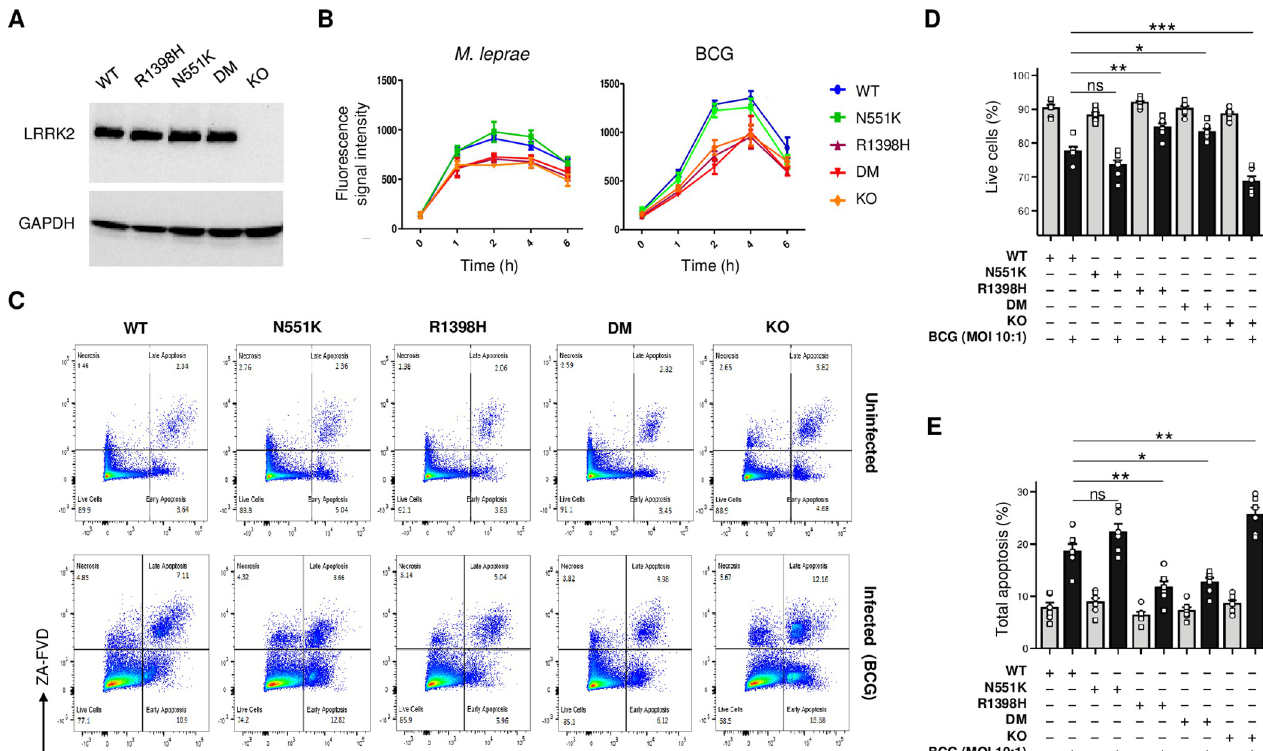
Fig 2. Effects of LRRK2 variants on respiratory burst and apoptosis in response to pathogens. (A) Protein levels in RAW264.7 cells of LRRK2 WT, LRRK2 mutants [N551K, R1398H and DM] and no LRRK2 protein (KO). The result is a representative of three independent experiments done by Western blot analysis. The expression of GAPDH is shown as a loading control. (B) Kinetics of reactive oxygen species (ROS) production in cells with different Lrrk2 genotypes after stimulation with live M . leprae (left panel) or BCG (right panel). Results present the mean ± SE for three independent experiments (done in triplicates). (C-E) Effect of LRRK2 mutations on apoptosis in response to BCG compared to uninfected cells. (C) Flow cytometry for apoptosis, which is a representative of two independent experiments (done in triplicates) with similar results. D-E Percentages of live cells ( D ) and total apoptotic cells ( E ) were calculated in uninfected (grey bars) and BCG-infected cells (black bars) expressing different LRRK2 variants. ( D-E ) Data is presented as mean ± SE (n = 6). The two experiments are represented as circles and squares. ** 0.001 � P < 0.01; * 0.01 � P < 0.05.